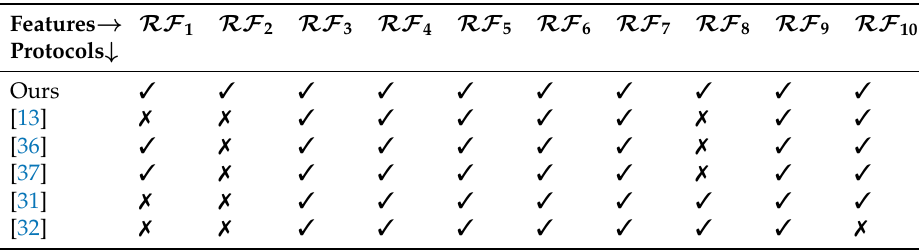
Table 2. Security Comparison